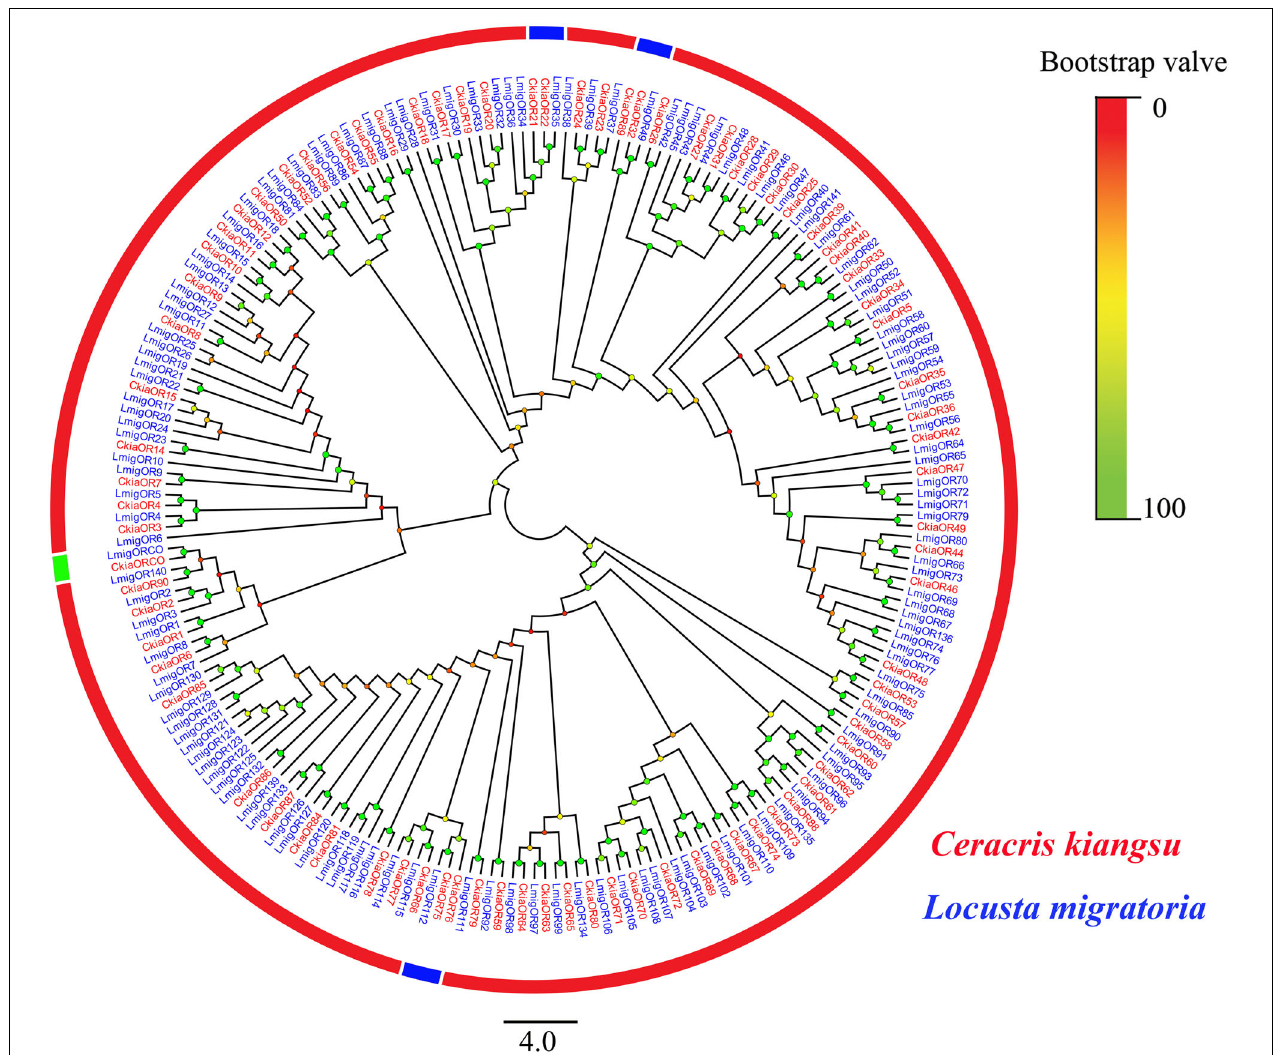
FIGURE 2 | Phylogenetic tree of putative odorant receptors (ORs) from C. kiangsu and other insects. Branch support (circles at the branch nodes) was estimated using bootstrap values based on the scale indicated on the top right.